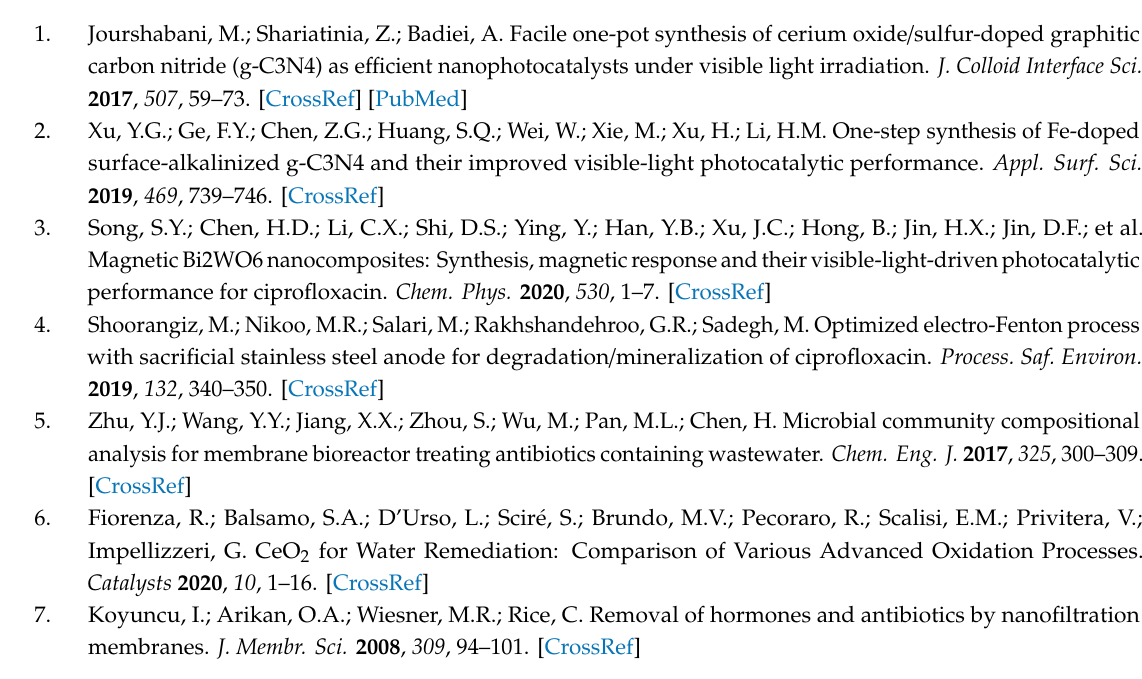
Figure S1. (b–f) element mapping of C, N, O, Si, and Ce for kaolin / CeO 2 / g-C 3 N 4 composite, the upper left corner (a) shows the corresponding images. (g) EDS spectrum; Figure S2. The changes in UV-vis spectra of CIP in liquid phase over kaolin, CeO 2 , g-C 3 N 4 , kaolin / CeO 2 , kaolin / g-C 3 N 4 and CeO 2 / g-C 3 N 4 composite vs irradiation